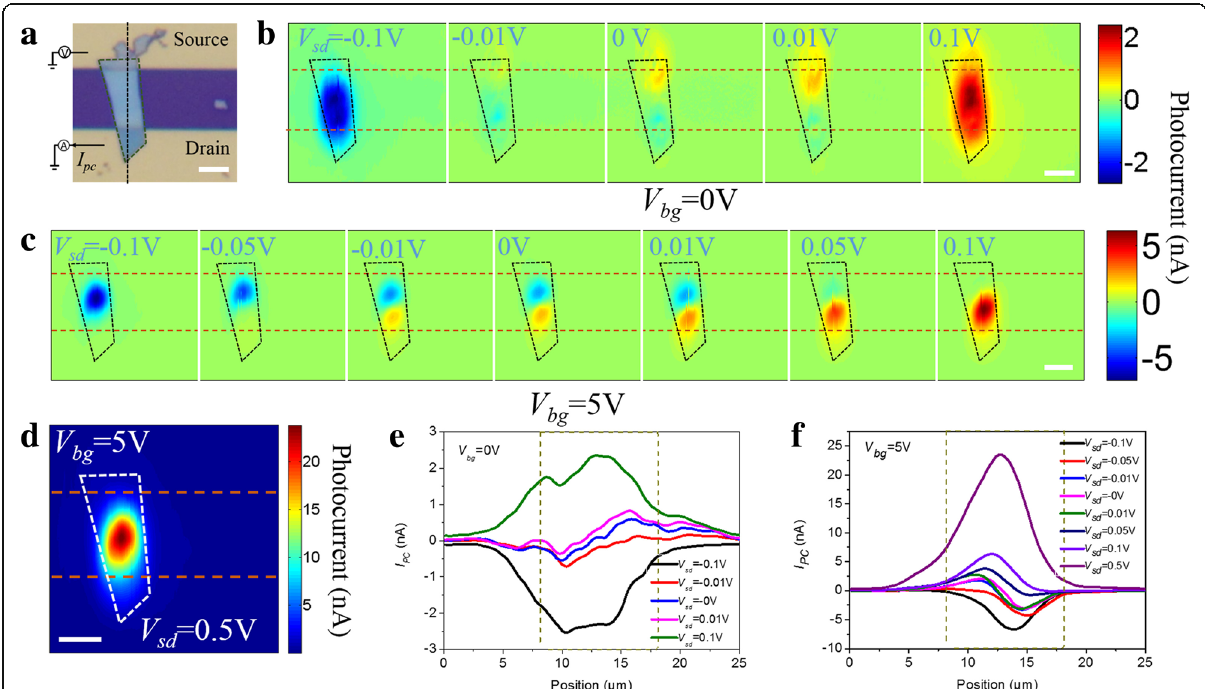
Fig. 4 Spatial-resolved photocurrent images of D1 as a function of V sd . a The optical image together with the electrical setup. b Spatial-resolved photocurrent images at V bg =0 V and V sd = − 0.1, 0.01, 0, 0.01, and 0.1 V, respectively. c Spatial-resolved photocurrent images at V bg =5 V and V sd varies from − 0.1 to 0.1 V. d Spatial-resolved photocurrent images at V bg =5 V and V sd =0.5 V. e I PC profile at V bg =0 V and f I PC profile at V bg =5 V taken along dashed line in Fig. 4a. The scale bars are 5 μ m in all